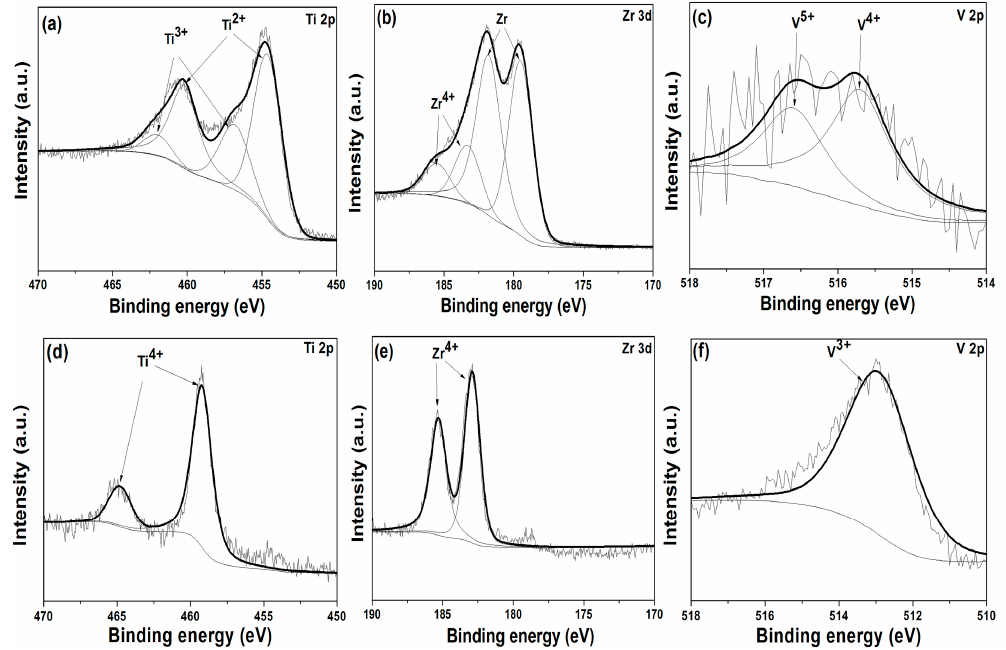
Figure 5. The X-ray photoelectron spectroscopy (XPS) spectra of Ti 2p, Zr 3d, and V 2p species obtained from Φ 2 and Φ 6 mm Ti 46 Zr 20 V 12 Cu 5 Be 17 rods. ( a – c ) for the Φ 2 mm rod and ( d – f ) for the Φ 6 mm rod (the black lines are fitted lines and the gray lines are raw data).